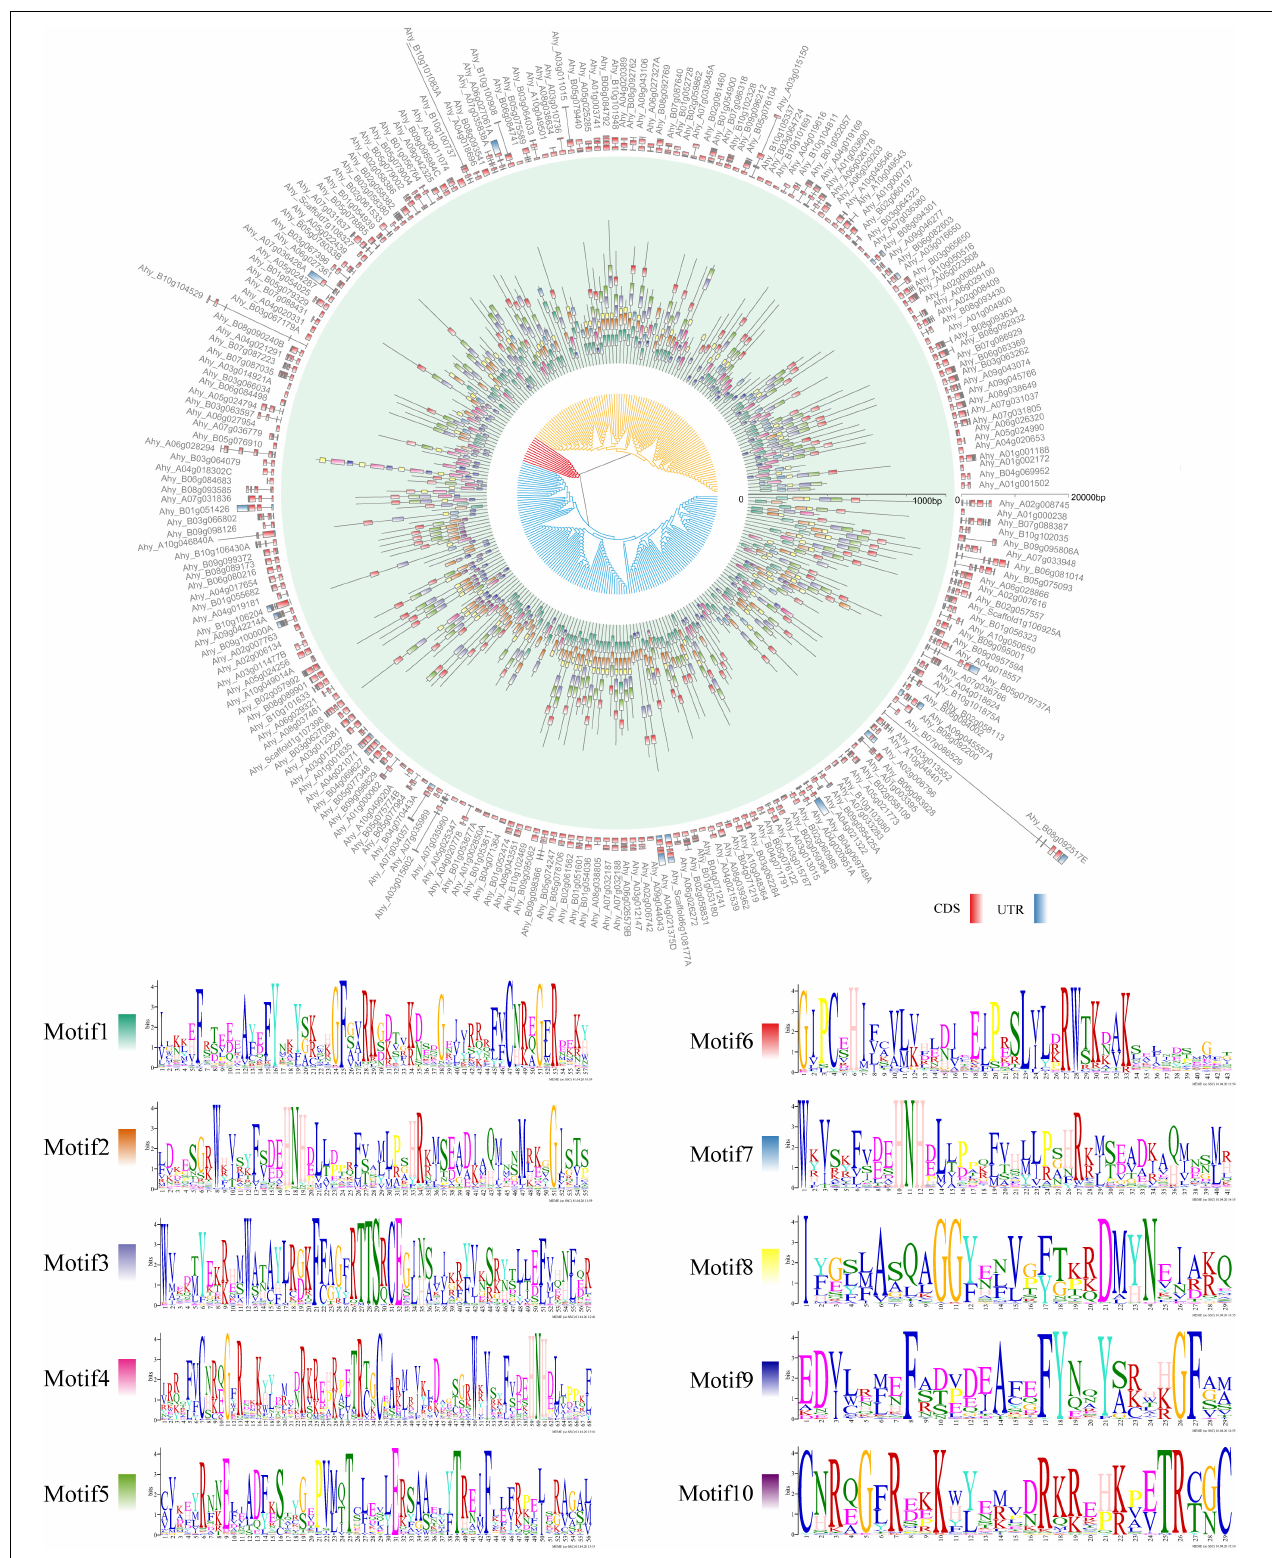
FIGURE 2 | Comparative gene structure, phylogenetic tree, and motif analysis of AhFAR1 genes. Inner, middle, and outer circle represent phylogenetic tree, motif, and gene structure, respectively.